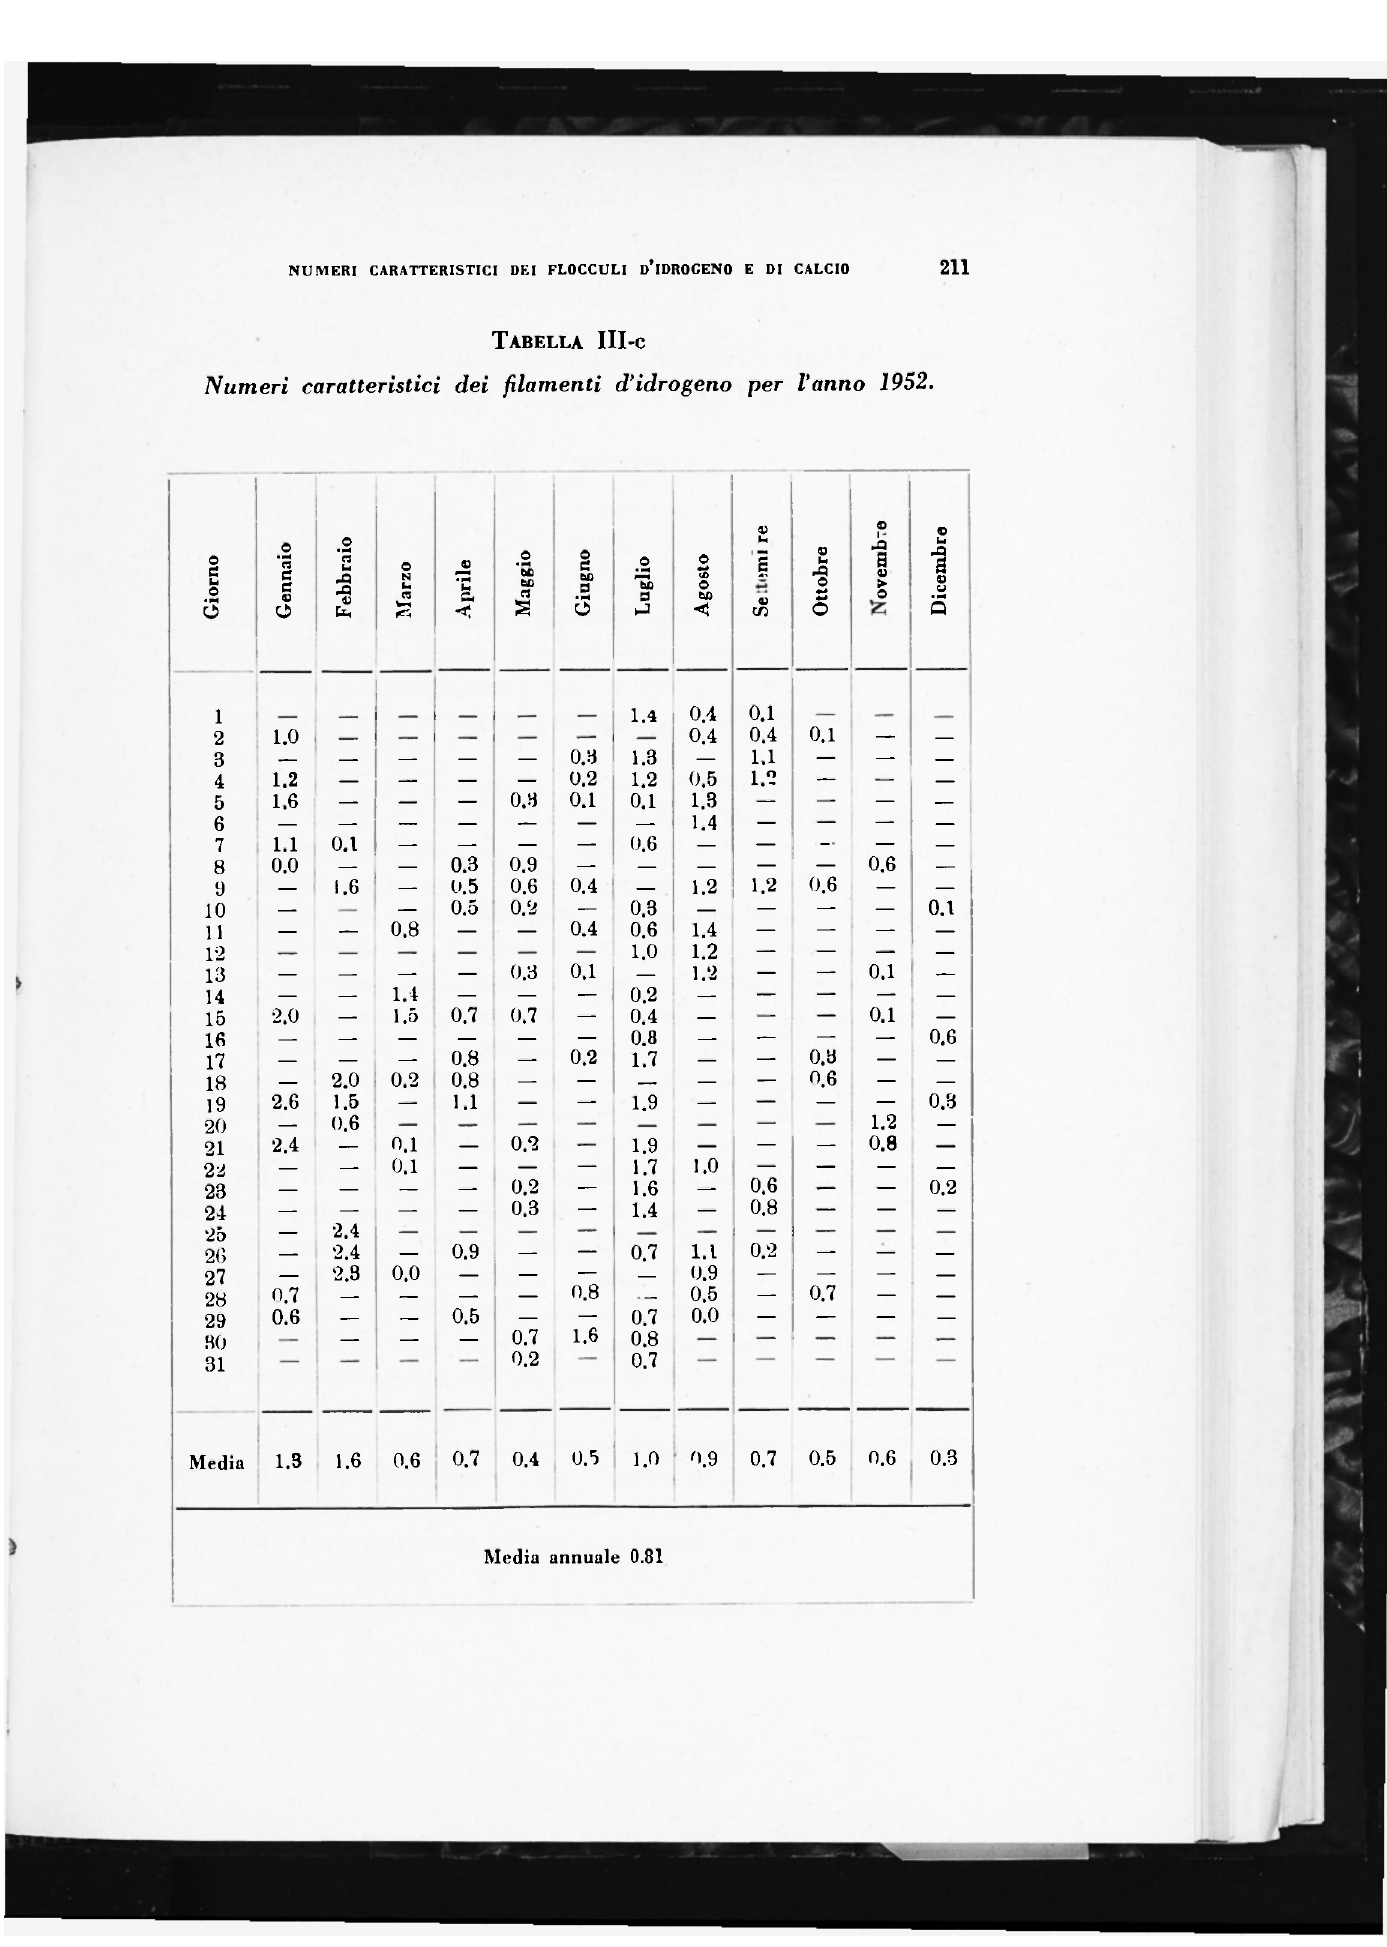
Numeri caratteristici dei